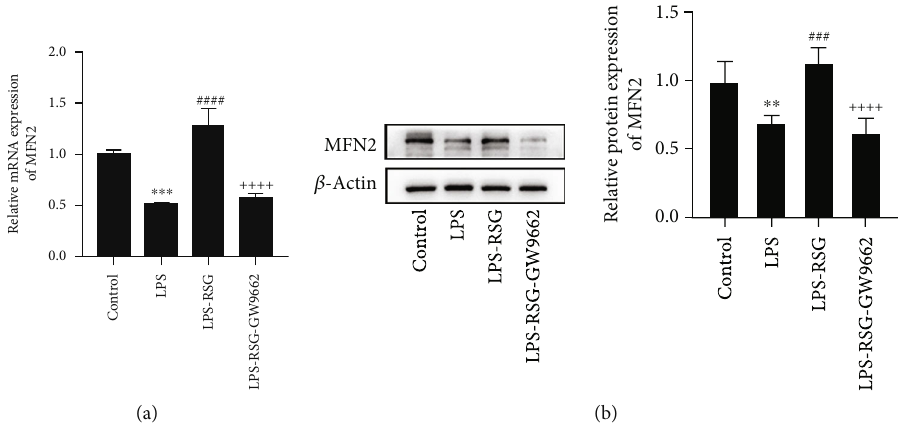
Figure 5: Activation of PPAR γ promoted MFN2 expression in alveolar epithelial cells. (a) Relative mRNA expression of MFN2, (b) Western blotting and relative protein expression of MFN2. Data are presented as mean ± SD . ∗∗ p < 0 : 01 , ∗∗∗ p < 0 : 001 vs. Control; ### p < 0 : 001 , #### p < 0 : 0001 vs. LPS; ++++ p < 0 : 0001 vs.